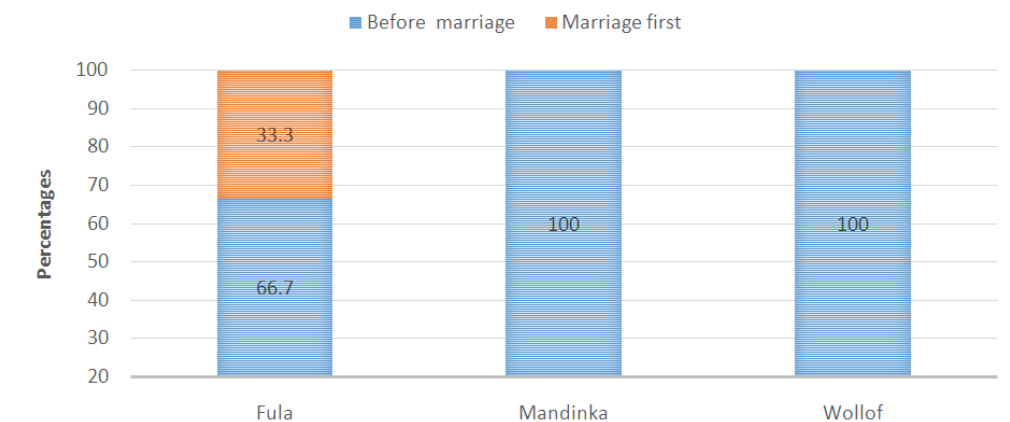
Figure 2. First sexual encounter and marriage: What came